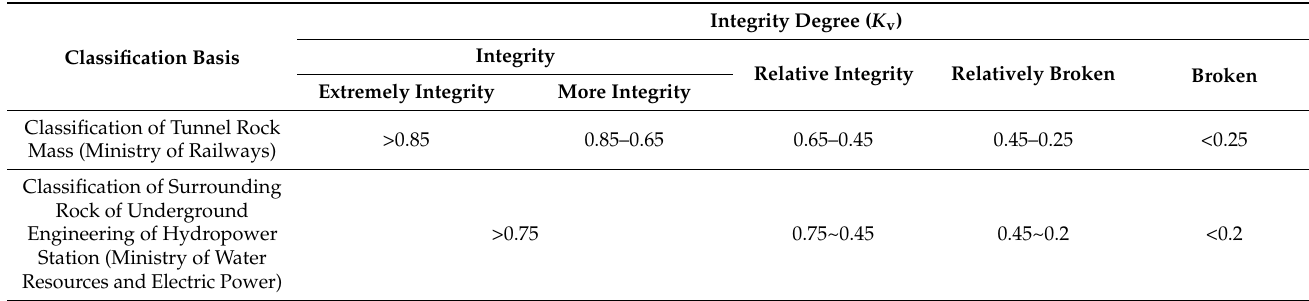
Table 1. Degree of integrity degree ( K v